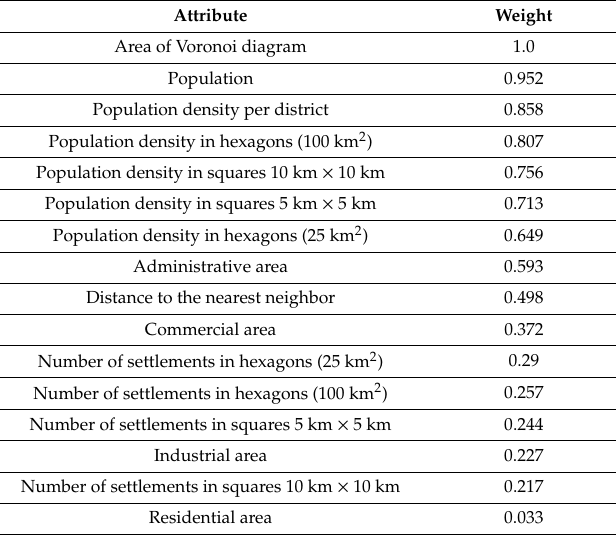
Table 5. Normalized weights of settlement attributes, calculated using the DT-GA model. Calculated for all four district